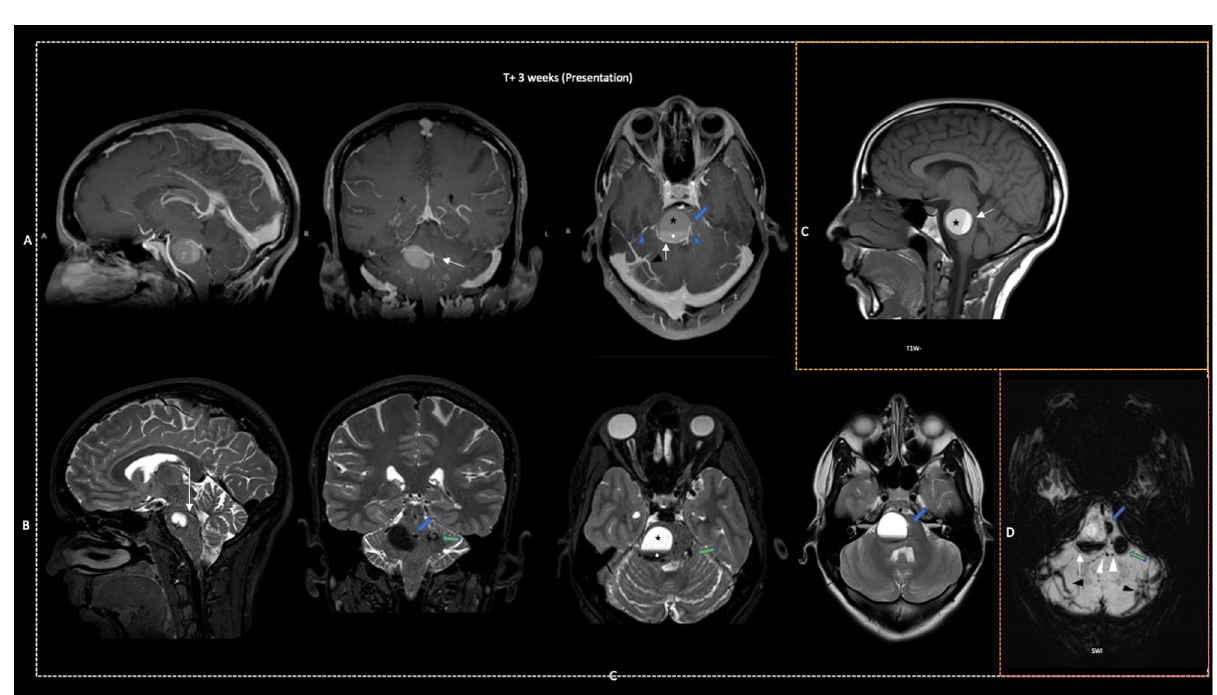
FIGURE1 Pre-operative (first surgery). Sagittal, coronal, and axial MRI: (A) T1W + Gad; (B) T2W; sagittal only: (C) TW1 and axial only: (D) SWI. Showing partly hyperacute hematoma (black star) of T1W isointense and T2W hyperintense signal. Early subacute hematoma portion (white star) of T1W hyperintense and T2W hypointense signal. Associated: Two CCMs (target/culprit—blue arrow; incidental contralateral cerebellar peduncle—green arrow) seen as blooming artifacts on SWI, popcorn appearance of mixed signal intensity on T2W, outline against the medial aspect of hematoma cavity on T1W-DVA with a retrospectively determined smaller caliber of its main draining vein (white arrow) seen on T1W + Gad filling, serpiginous flow void on T2W and SWI. Draining via multiple collector veins on T1W + (blue arrowheads) into caput medusae appearance of transcerebellar veins on SWI (black arrowhead). Prominent channels can be seen connecting both CCMs likely due to high pressures (white arrowheads on